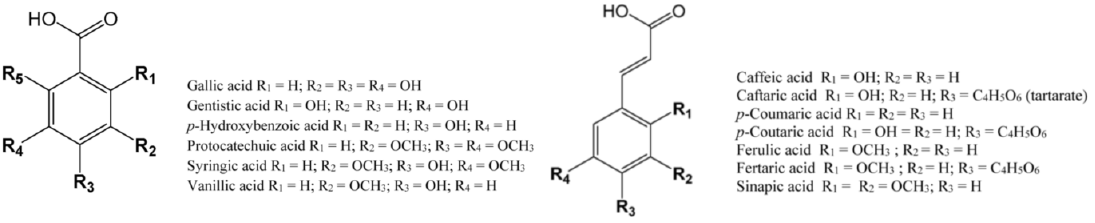
Figure 1. Structural formulas of grape phenolic acids